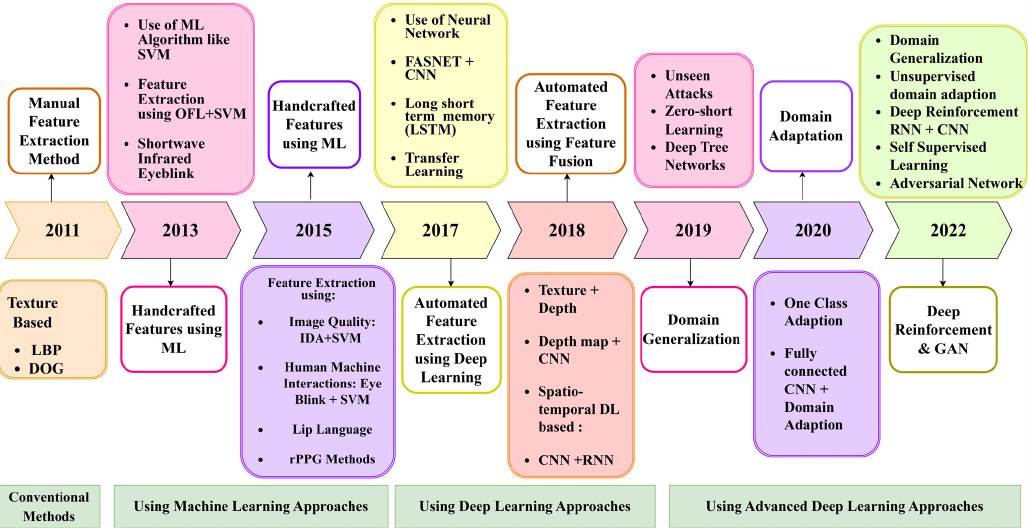
Figure 1. Progression of face liveness detection systems.